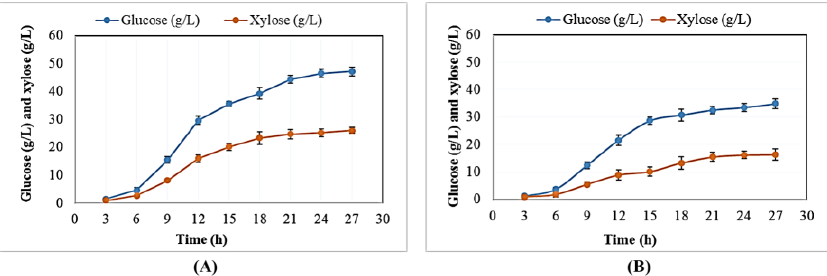
Figure 1. Glucose and xylose production during the enzymatic hydrolysis of organosolv pretreated Brewers’ spent grain (BSG) ( A ) and microwave assisted alkaline pretreated BSG ( B ). 2.2. Optimization of the C/N (g/g) Ratio for Lipid Accumulation of R.